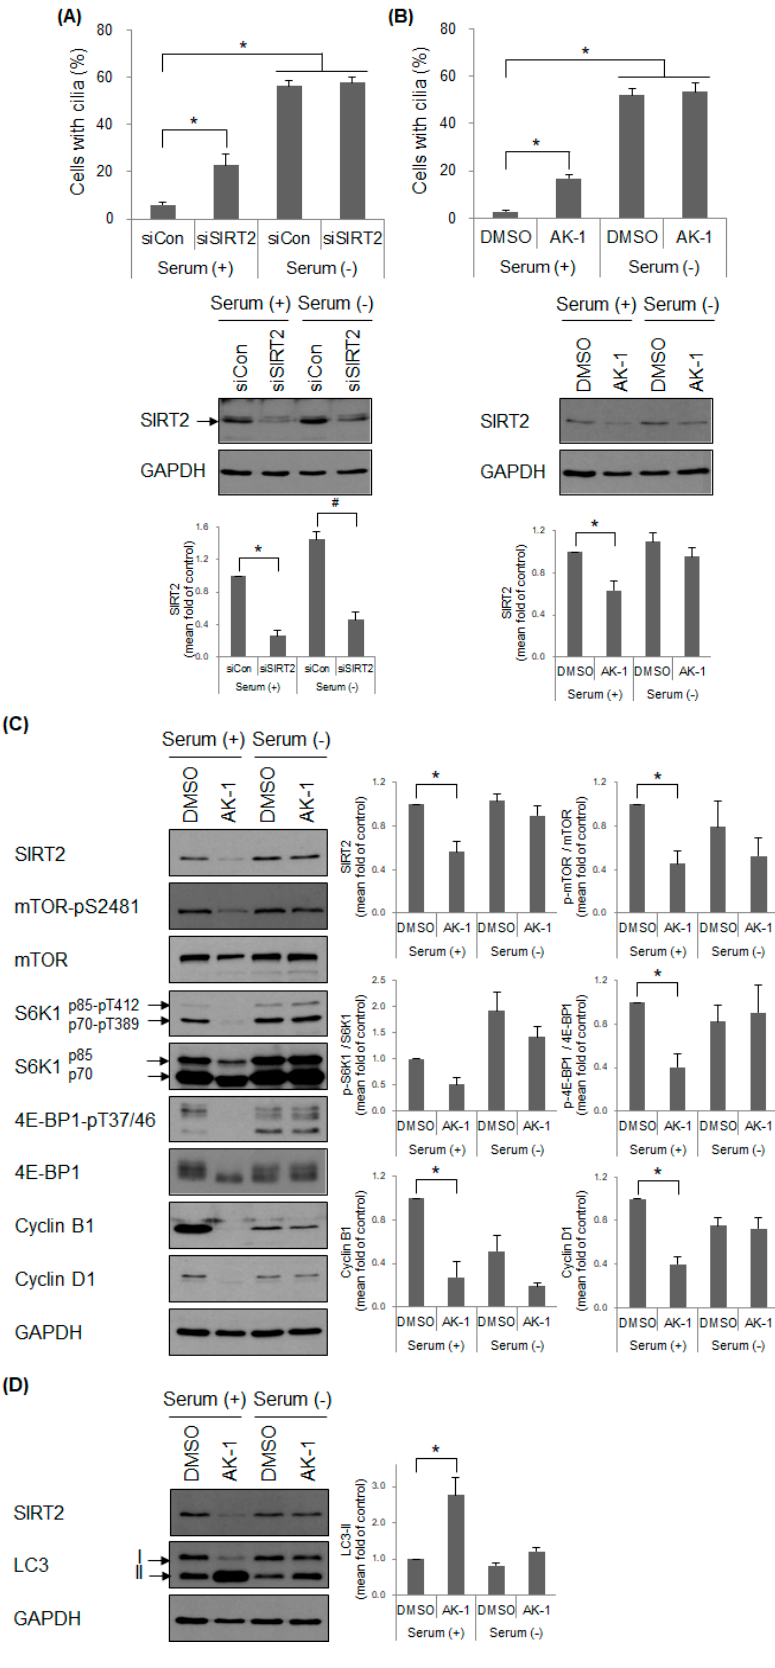
Figure 4. SIRT2-regulated cilia formation and mTOR signaling is dependent on serum. ( A – D ) hTERT-RPE1 cells were transfected with control siRNA (siCon) or SIRT2-targeting siRNA (siSIRT2), or treated with 0.1% DMSO or 10 μ M AK-1 in the presence or absence of serum for 48 h. ( A , B ) The number of ciliated cells (out of 200 cells) was counted and the result was expressed as the mean ± SEM ( n = 5). * p < 0.05; significantly different from siCon-transfected or DMSO-treated cells in the presence of serum (one-way ANOVA followed by Tukey’s HSD test). ( A – D ) Expression of SIRT2, mTOR, its substrates, cyclins, and LC3 was determined by Western blotting. Relative expression is presented as the mean ± SEM ( n = 6). * p < 0.05 and # p < 0.05; significantly different from control cells in the presence and absence of serum, respectively (Kruskal–Wallis test followed by Dunn’s multiple comparison). 2.5. Inhibition of mTOR Induces a Non-Proliferating Status and Increases Primary Cilia Formation Finally, we investigated whether the effects of mTOR inhibition are similar to those of SIRT2 suppression. ATP-competitive mTOR inhibitors torin 1 and rapamycin inhibit mTORC1/mTORC2 and mTORC1, respectively [50]. mTOR activity was inhibited by treatment of torin 1 and rapamycin in hTERT-RPE1 cells. As expected, the levels of mTOR-pS2481 and p70S6K1-pT389/p85S6K1-pT412 decreased significantly in both torin 1- and rapamycin-treated cells (Figure 5A). In addition, the level of LC3-II increased in both torin 1- and rapamycin-treated cells (Figure 5A). Unexpectedly, the level of SIRT2 also increased in torin 1- and rapamycin-treated cells, suggesting that mTOR acts as a